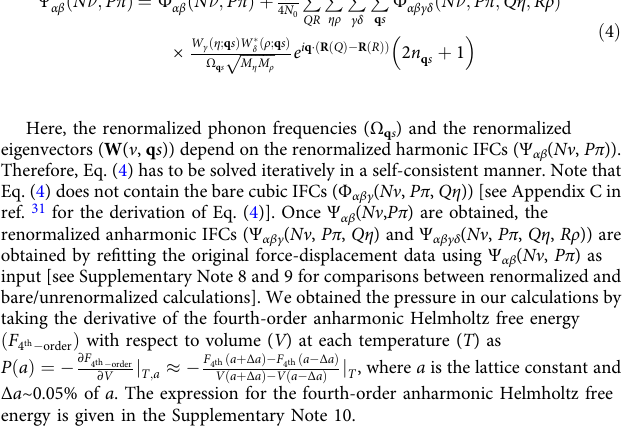
Table 1. For the force-displacement calculations, we used thermal snapshots on 5× 5× 5 supercells of atoms (250 atoms per supercell). Using the computational parameters listed in Table 1, the total energy converged to less than 9 ×10 − 4 Ry per unit cell, the total stress converged to less than 0.8kbar per unit cell and the forces on atoms converged to less than 10 − 5 Ry/au. The phonon frequencies and eigenvectors were unchanged by adding one more shell of harmonic IFCs. All reported thermal conductivity values are converged with respect to the number of snapshots, number of nearest neighbors of the anharmonic (cubic and quartic)